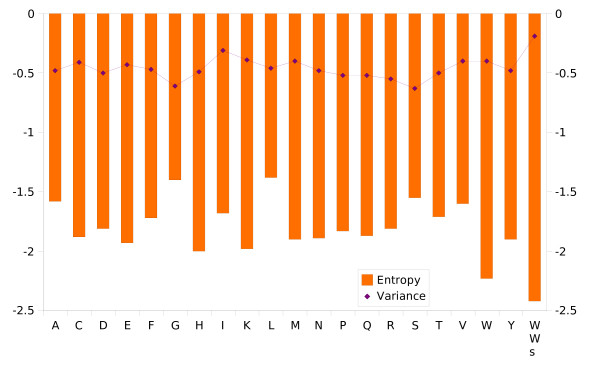
A plot of entropy versus optimal sequence residue. Bars in orange show the mean relative entropy for each of the 20 amino acids. Entropy is shown on log scale. Amino acid type for each residue position was determined from the optimal sequences generated from the PSI-BLAST profiles and came from searches of the Combined-nr. The bar marked "WW" refers to tryptophans in repeats. The purple line shows the variance of the relative entropy. Positions with repeat tryptophans clearly have the lowest mean entropy and the lowest variance.